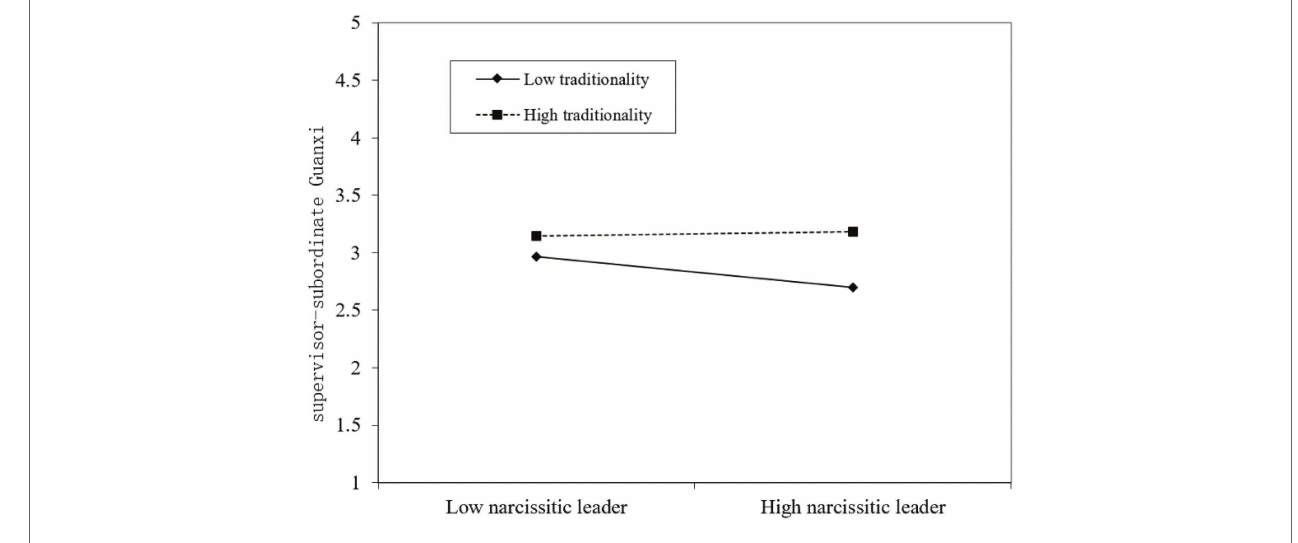
FIGURE 2 | Moderating effect of